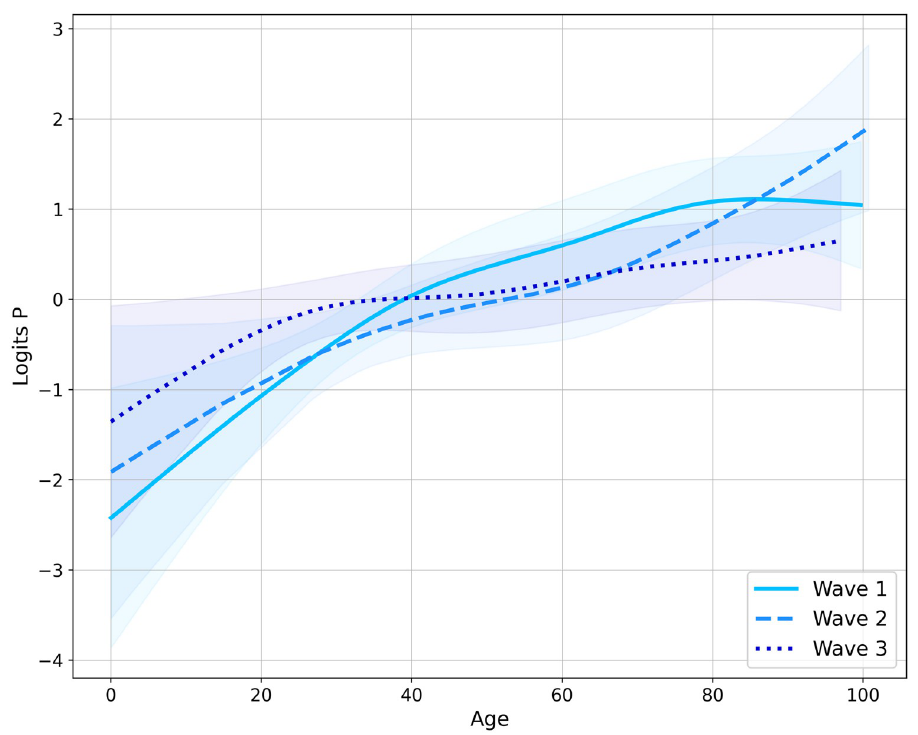
Fig 1. Spline transformation of Age for each wave. Shaded areas represent confidence intervals.